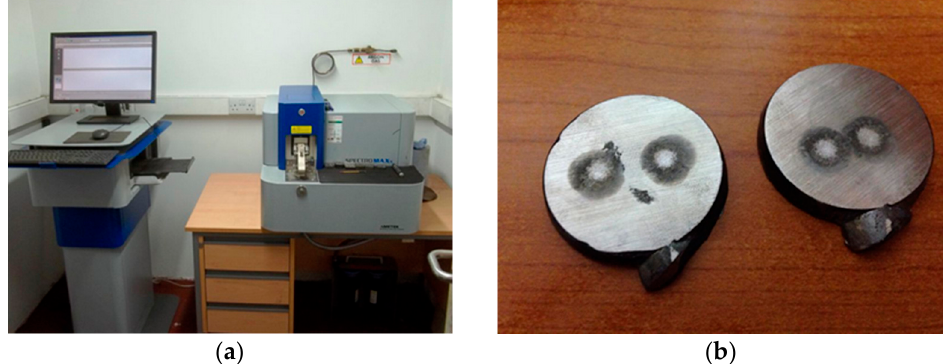
Figure 7. Equipment and samples used for chemical analysis ( a ) the SPECTROMAXx chemical analysis spectrometer of Benninger Guss AG. ( b ) Surface of the samples after chemical analysis performed with the spectrometer.